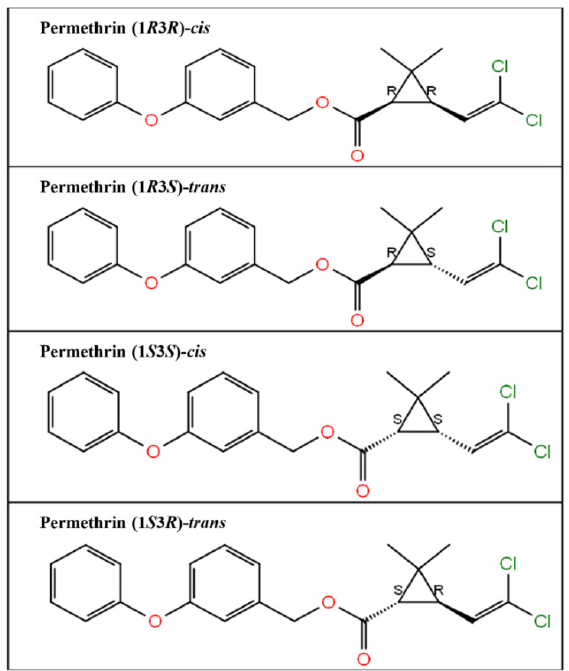
Figure 1. Two-dimensional structure of the four stereoisomers of permethrin, i.e., permethrin (1 R 3 R )- cis , permethrin (1 R 3 S )- trans , permethrin (1 S 3 S )- cis , and permethrin (1 S 3 R )- trans